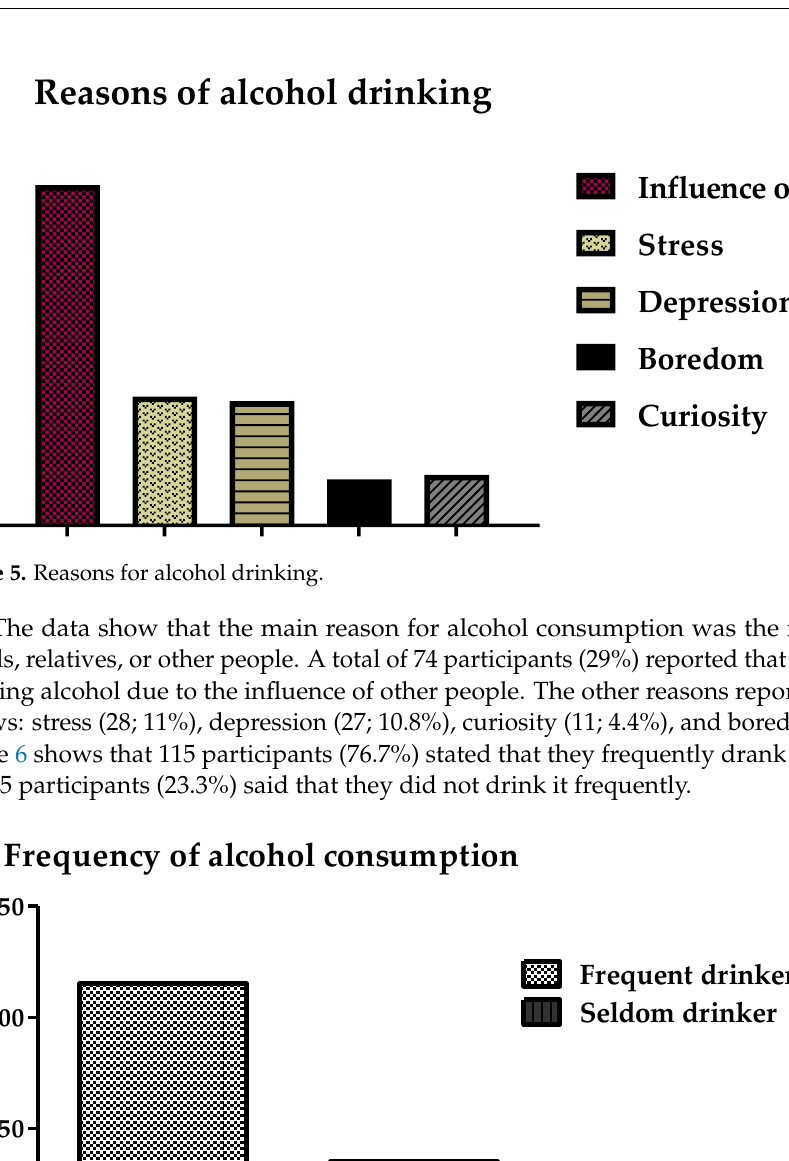
Figure 6. Frequency of alcohol consumption among the participants.